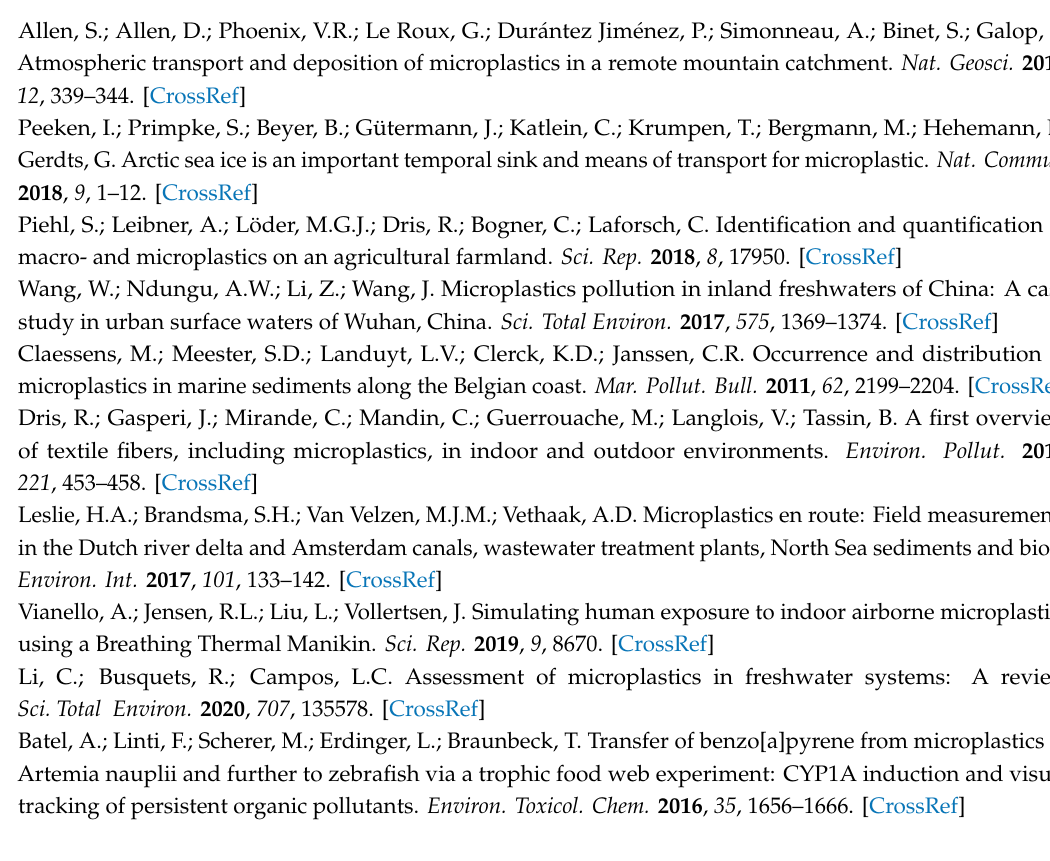
Table S1: Size ranges (in µ m) and counted particle numbers (per mL) of polystyrene particles in the stock suspension. Table S2: Volume of changed test medium in each Petri dish / tank during experiment 1 and experiment 2. Table S3: Average measured water parameters of the experiment 1b. Table S4: Average measured water parameters of the experiment 2. Table S5: Operating parameters of the triple quadrupole MS (Agilent 6490 QqQ) in positive mode. Table S6: Specific measurement parameters for amitriptyline with LC-QqQ in water samples. Intraday variations (RSD) is calculated with 1 µ g / L standard (10 µ L injection volume and 4 replicates (n)). Limit of quantification = LOQ. Table S7: Parameters for the determination of the lipid peroxide content in the di ff erent experiments. Table S8: Used data transformations for the statistical analysis. Table S9: Summary of all p-values of the single comparisons of the di ff erent endpoints. CRED reporting. Raw data experiment 1. Raw data experiment